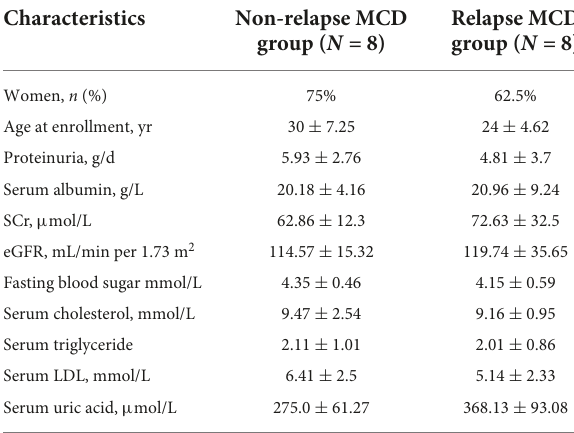
TABLE 1 Baseline characteristics of non-relapsed minimal change disease (MCD), relapsed MCD patients, and healthy controls with Raybiotech 440 cytokine antibody